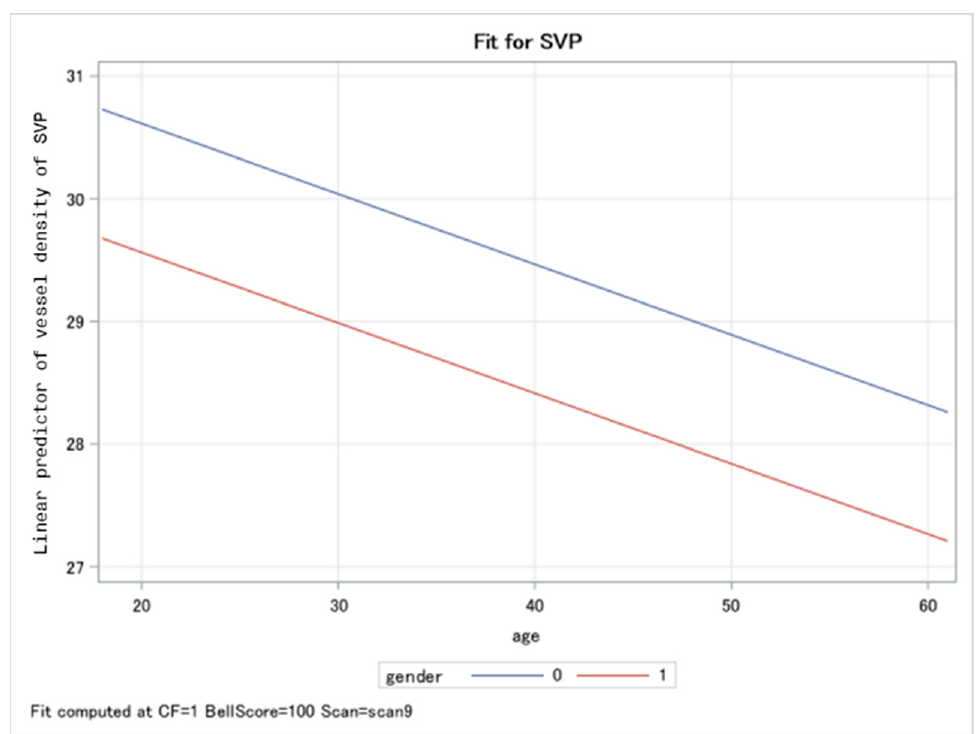
Figure 3. Panel plot overlaying the predicted values for male (blue line) and female (red line) vessel densities in the superficial vascular layer (SVP) among patients with post-COVID-19 symptoms: women patients showed significantly lower VDs in the SVP compared to men with increasing age. Table 1. Differences in least square means of vessel densities in the SVP, ICP and DCP in patients with post-COVID-19 syndrome (PCS, 1) compared to controls. SVP—superficial vascular plexus,